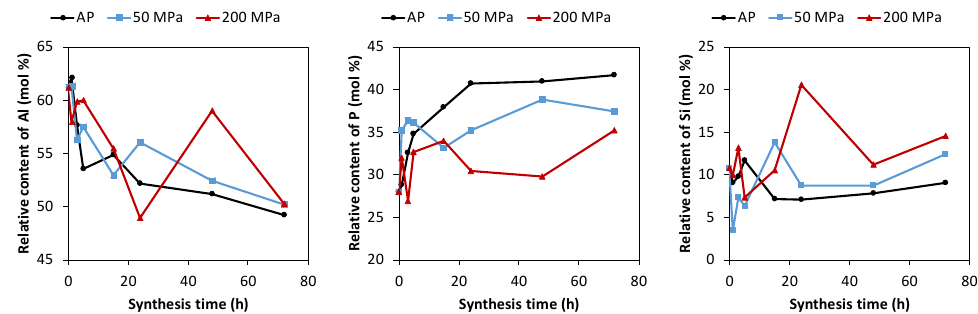
Figure 3. Chemical composition of the solids obtained under autogenous pressure (AP), 50 MPa and 200 MPa at different synthesis time using the diluted synthesis mixture (H 2 O/Al 2 O 3 = 50).